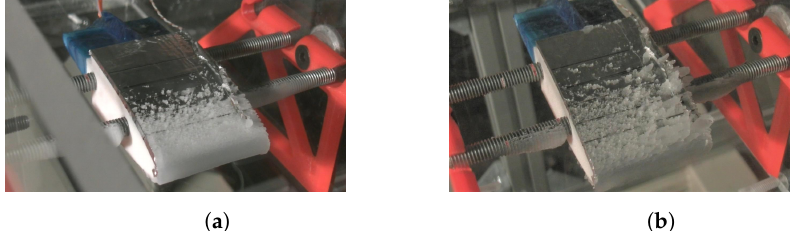
Figure 8. Pictures taken from IWT tests with:( a ) MVD = 20 µ m (Test case 13). ( b ) MVD = 70 µ m (Test case